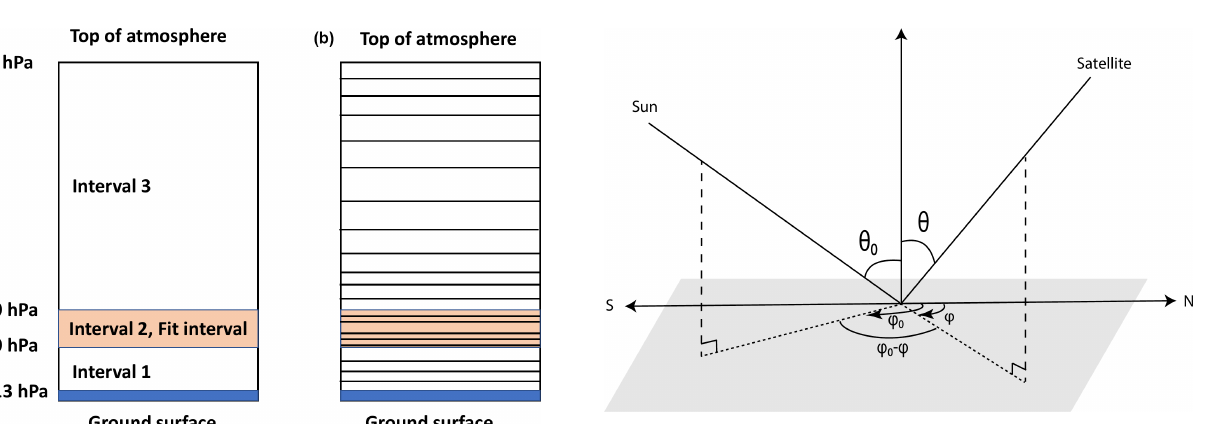
Figure 2. Schematic illustration of the altitude grid used in DISAMAR. (a) Pressure intervals in the atmosphere. (b) Each pres- sure interval is subdivided into layers using Gaussian division points in altitude, which are different per interval. The lowest level is the ground surface, and the highest level is the top of the atmosphere.